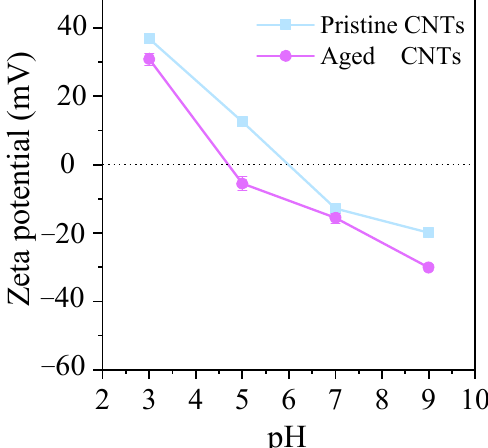
Figure 2. The zeta potential of pristine and aged CNTs. Table 2. Specific surface area and particle size distribution of pristine and aged CNTs.